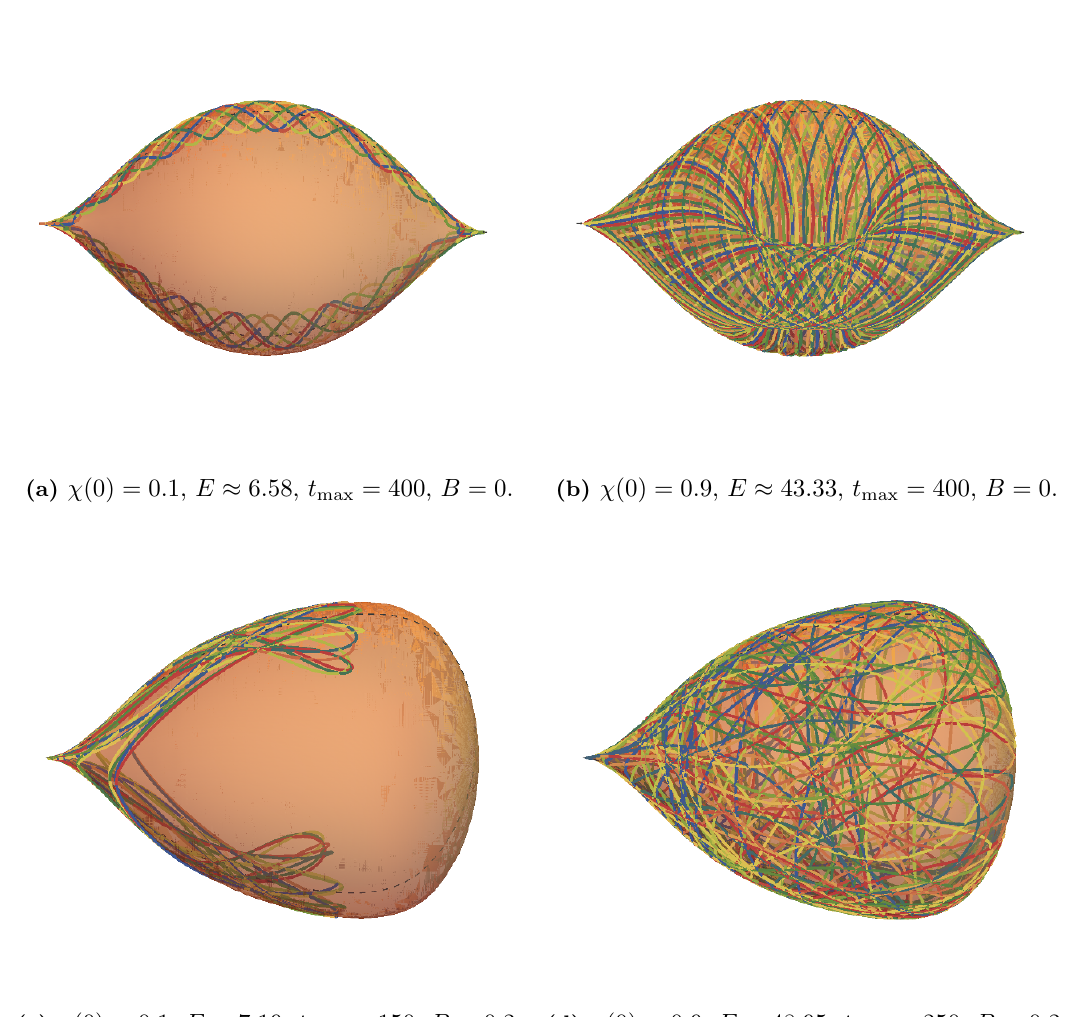
Figure 6. Trajectories of the string on the internal space M 3 for low and high energies (from left to right), for the embedding in eq. (3.2) with (cid:26) = ’ = (cid:21) = 0. The two images at the top correspond to the integrable background in eqs. (4.1){(4.3) with B = 0 in eq. (C.1), for those on the bottom B = 0 : 2. For the integrable background (in the top two images) the trajectories of the string soliton remain regular, even at high energies. We choose initial conditions p (cid:31) (0) = 0 ; z (0) = 2 ; p z (0) = 1. The orange surface corresponds to the angle (cid:31) (cid:12)bred over the z -interval with the warp-factor f 3 ( z ). The dashed line indicates the points where (cid:31) = 0 ; (cid:25) . Points on opposite sides of this line should be identi(cid:12)ed for (cid:12)xed values of z as (cid:31) 2 [0 ; (cid:25) ].